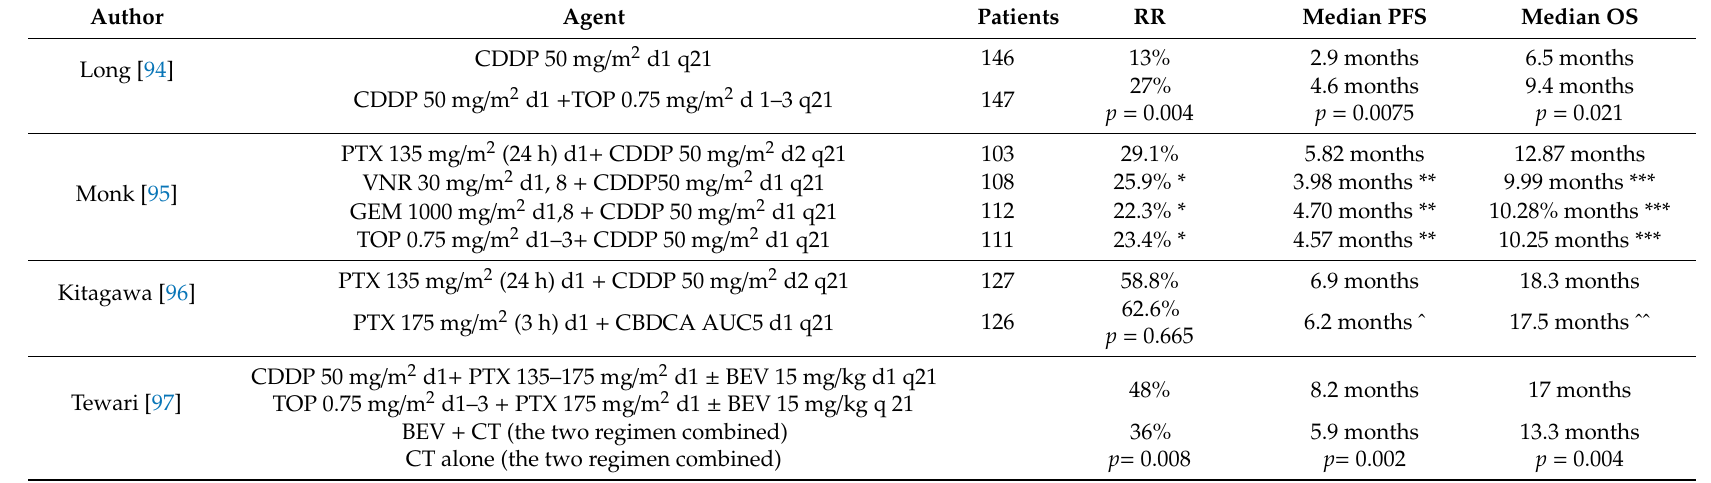
Table 3. Phase III trials of cisplatin-based chemotherapy in metastatic, persistent, or recurrent carcinoma of the uterine